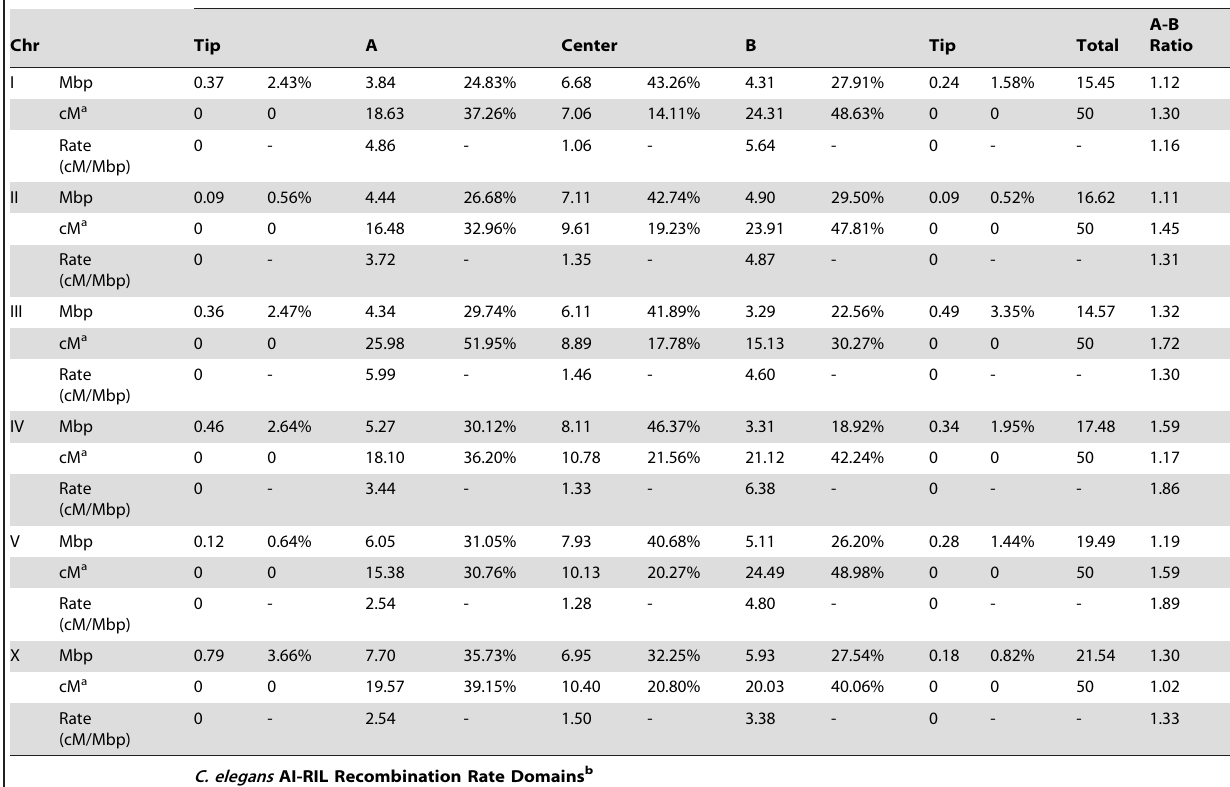
Table 3. Recombination domain comparison between C. briggsae and C. elegans